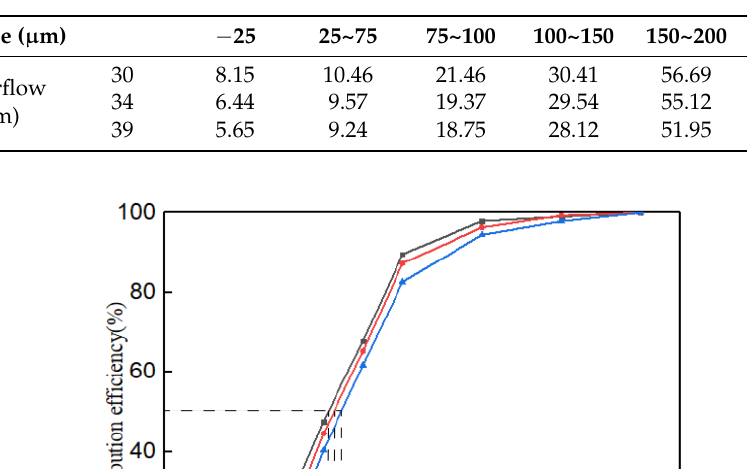
Table 4. Effect of the first-section overflow pipe diameter on cumulative particle size content.